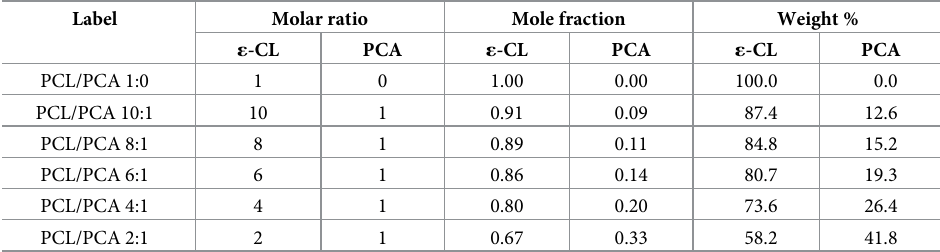
Table 1. Label, molar ratio, mole fraction, and weight % of the ε -caprolactone- p -coumaric acid copolymer prepared. Label